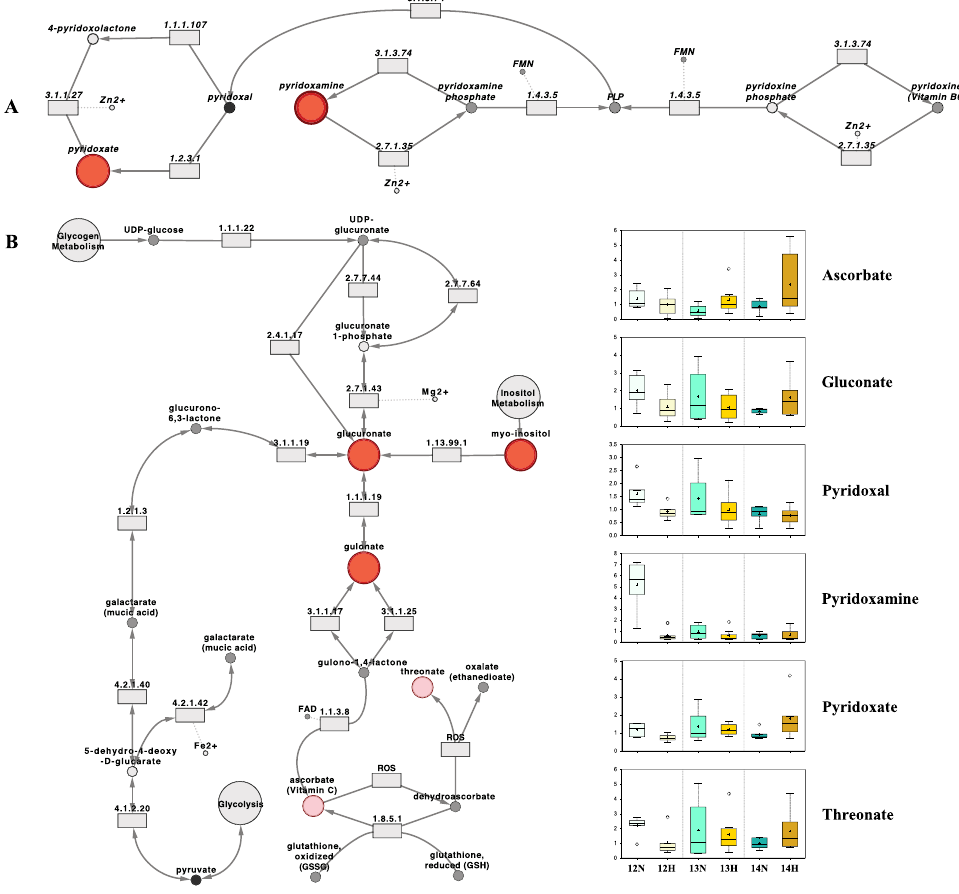
Figure 6. The ( A ) pyridoxal (vitamin B6), and ( B ) ascorbate (vitamin C) metabolic pathways in addition to the scaled intensities of relevant biochemicals. Biochemical node colour corresponds to day by progesterone (P4) interaction – dark red indicates a significant (p ≤ 0.05) interaction (node border thickness is inversely proportional to the magnitude of the p-value). Within these statistically significant nodes, node diameter is correlated to metabolic hierarchy (cofactor and intermediate metabolite nodes are smallest, followed by by-products, and central metabolites). Light red depicts an increasing trend (0.05 < p < 0.10), black depicts an identified amino acid which did not exhibit a day by progesterone interaction, and grey represents a biochemical present in the metabolic library but not detected in this study. Box plots: The y-axes are the relative metabolite concentrations, with the central horizontal line representing the median value with outer boundaries depicting the upper and lower quartile limits. Error bars depict the minimum and maximum distributions, with + representing the mean value and ○ the extreme data point. Abbreviations: Day 12 Normal P4 (12N), Day 12 High P4 (12H), Day 13 Normal P4 (13N), Day 13 High P4 (13H), Day 14 Normal P4 (14N), Day 14 High P4